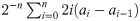
Properties of division trees as a function of v, the probability of self-renewal in compartments 1, …, n − 1.(a) Mean tree length, defined as the mean number of compartments involved in the division trees. (b) Mean division position. For an individual tree, sequence (1), this is defined as 2-n∑i=0n2i(ai-ai-1); plotted is the expectation of this quantity across all the trees. In this example, n = 4.